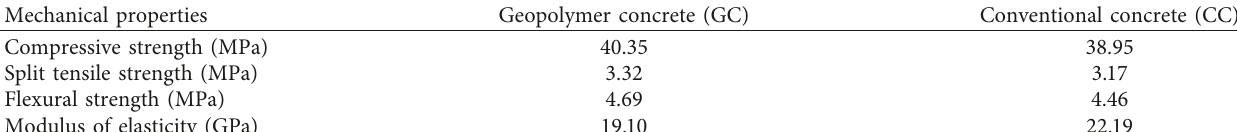
Table 2: Mechanical properties of geopolymer concrete and conventional